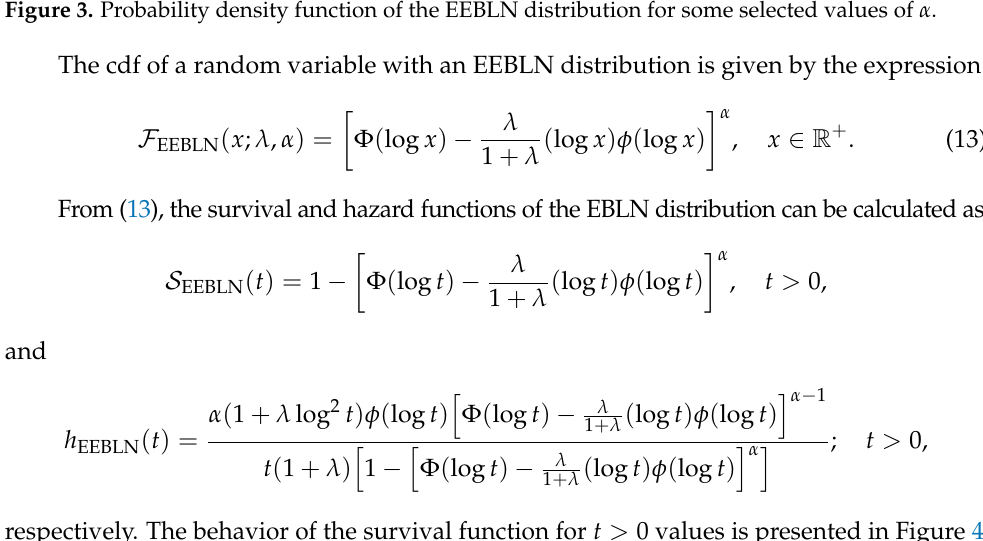
Figure 3. Probability density function of the EEBLN distribution for some selected values of α